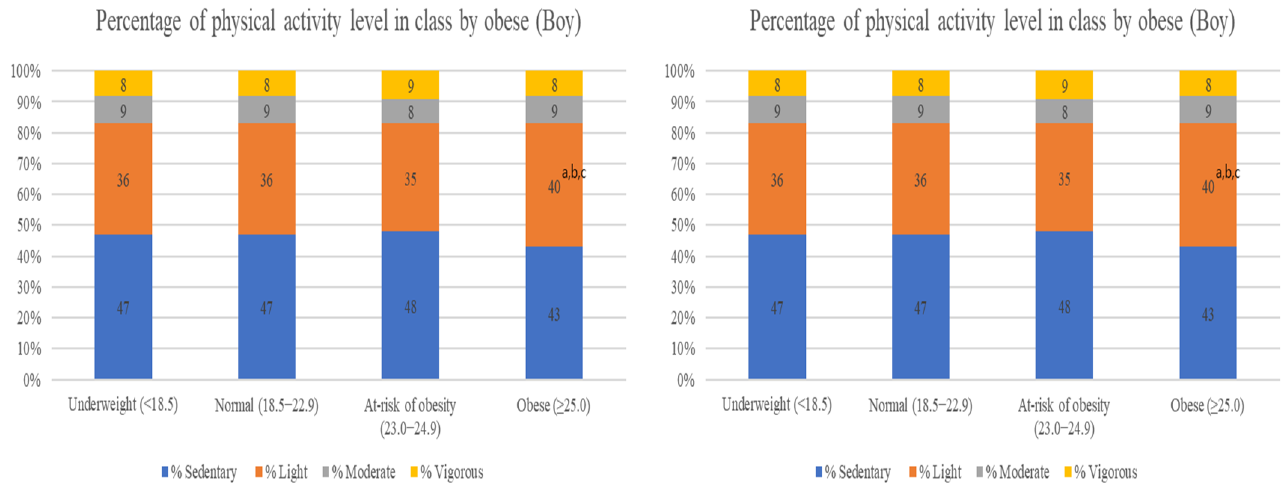
Figure 1. Percentage of physical activity level in class by obese. Data are presented as mean ± standard deviation; one-way analysis of variance. a p < 0.05 compared with the underweight group. b p < 0.05 compared with the normal group. c p < 0.05 compared with the at-risk for obesity